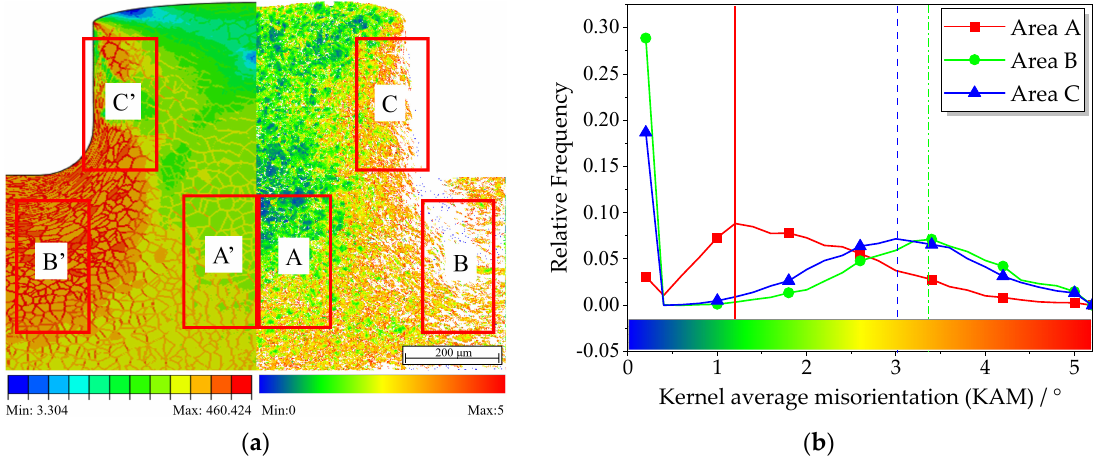
Figure 18. KAM distributions (2nd nearest ‐ neighbor): ( a ) Global; (Here, blue and red color indicate the minimum value and maximum value, respectively); ( b ) Three areas.